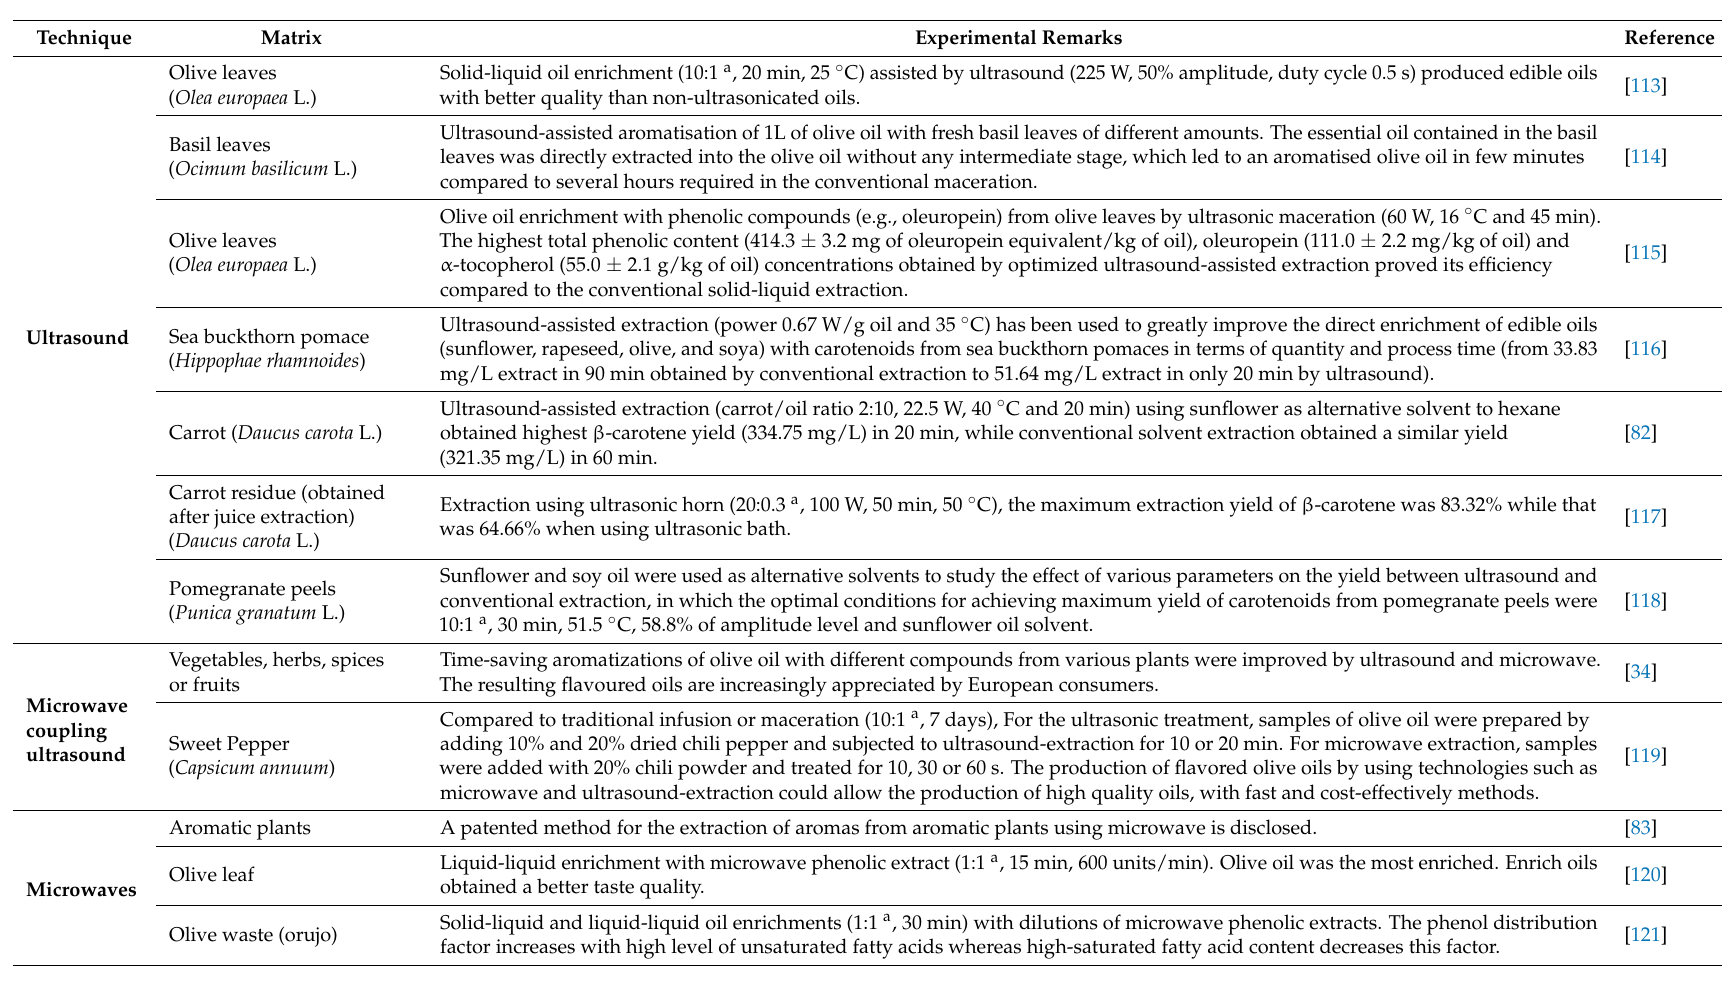
Table 2. Innovative techniques applied in the extraction of bio-active compounds using vegetable oils as solvents.